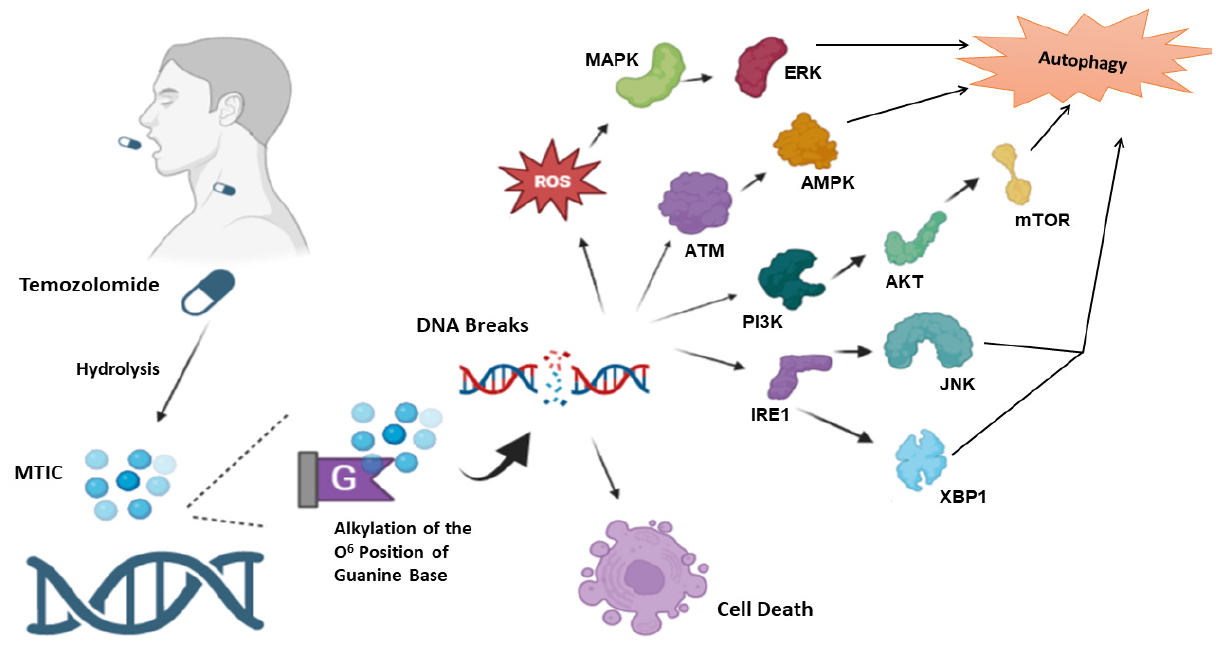
Figure 1. Mechanism of action of temozolomide and relationship with autophagy.